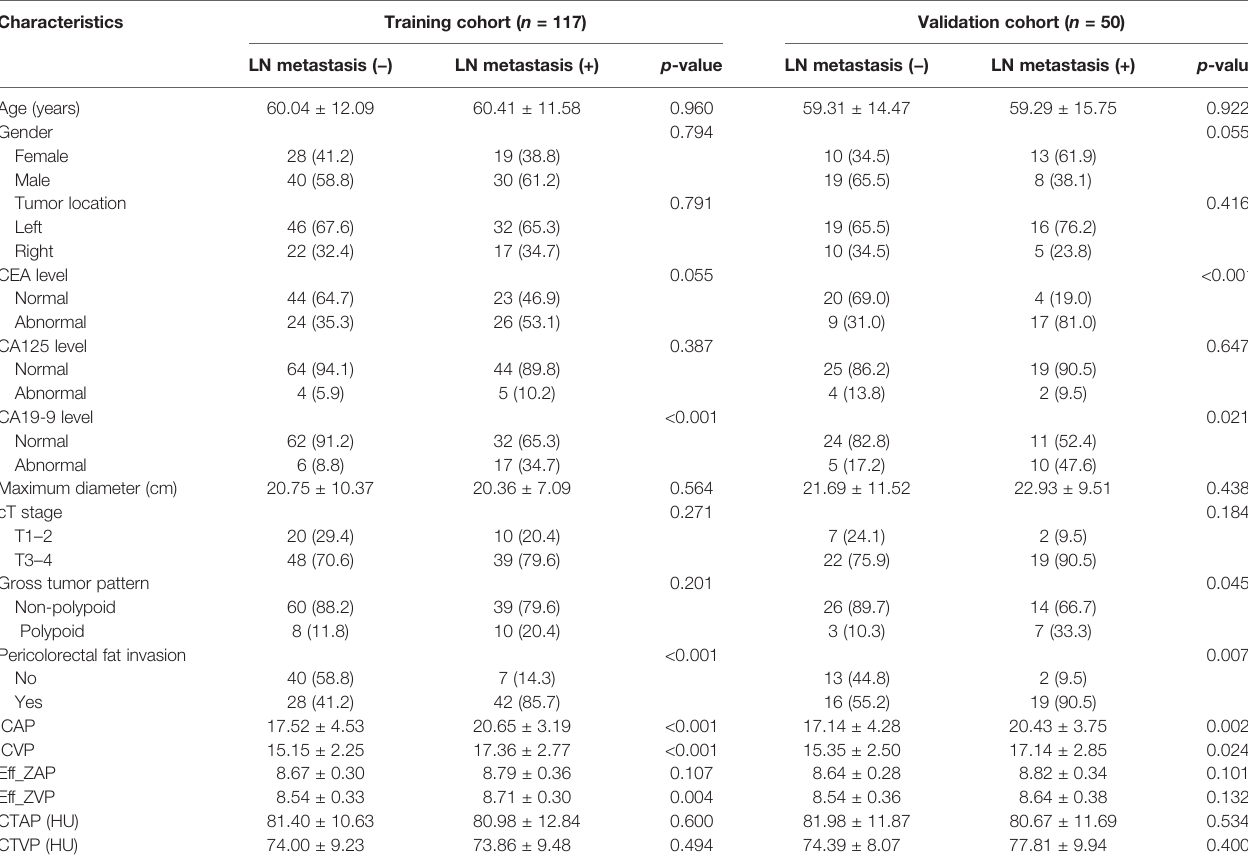
TABLE 1 | Clinical characteristics and DESCT parameters of CRC patients [mean ± SD or no. (%)].